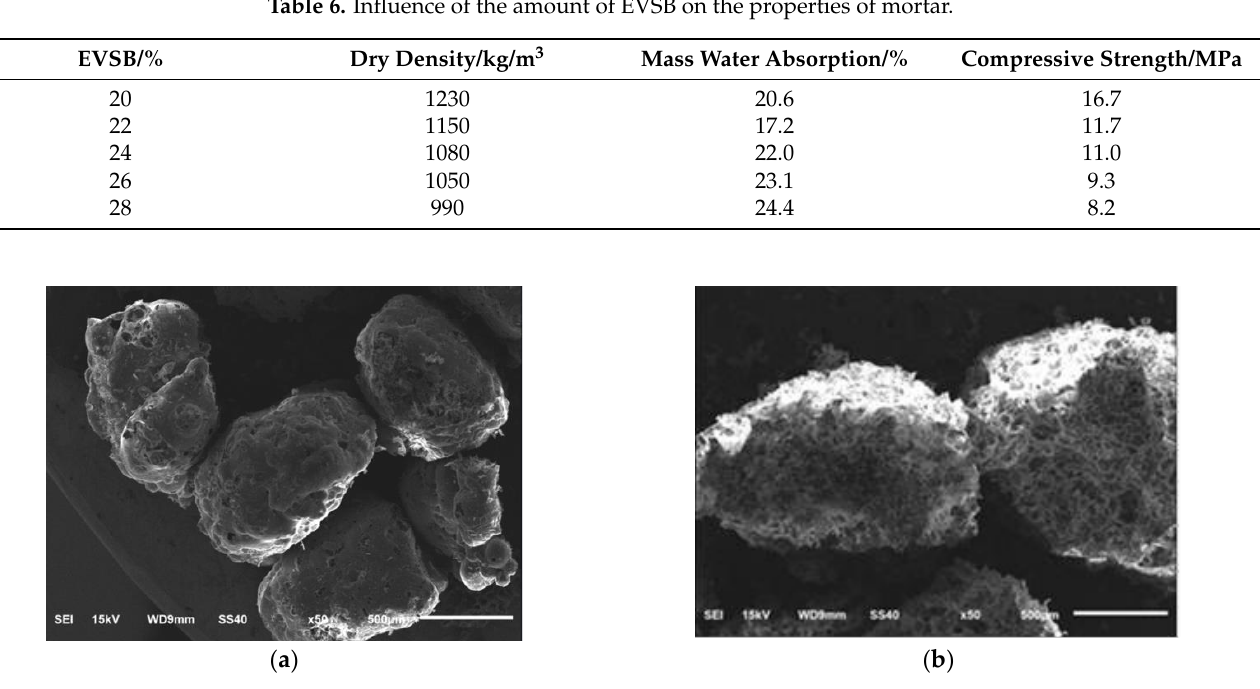
Table 6. Influence of the amount of EVSB on the properties of mortar.